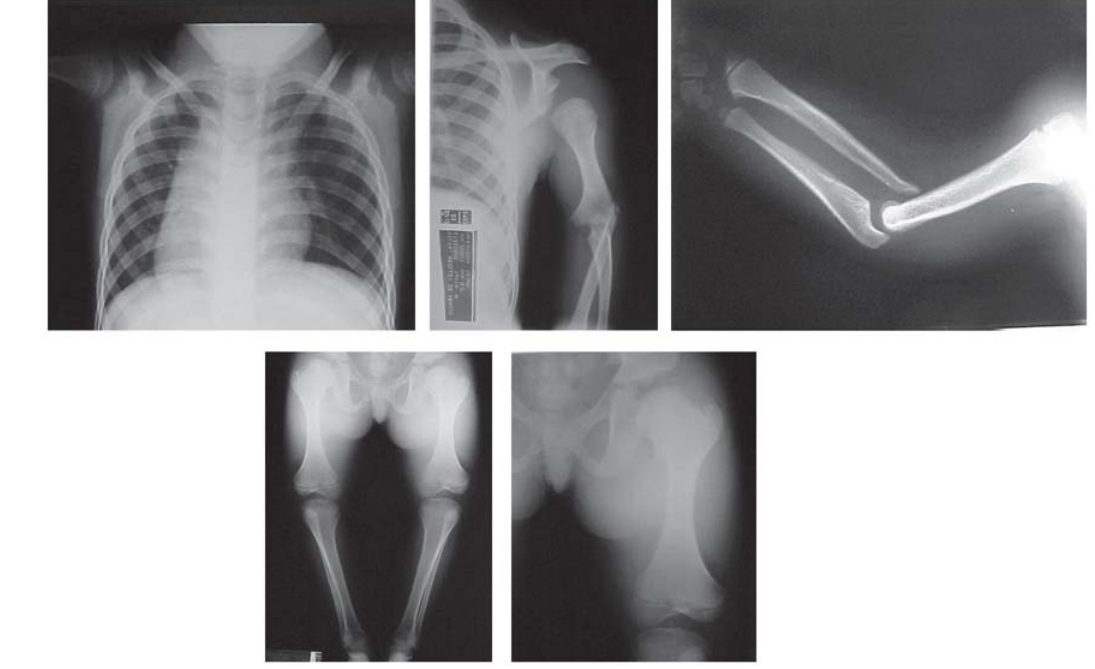
Fig. 2 – Skeletal survey showing the shortened humeri and femora, radial dislocation and radioulnar diastasis.